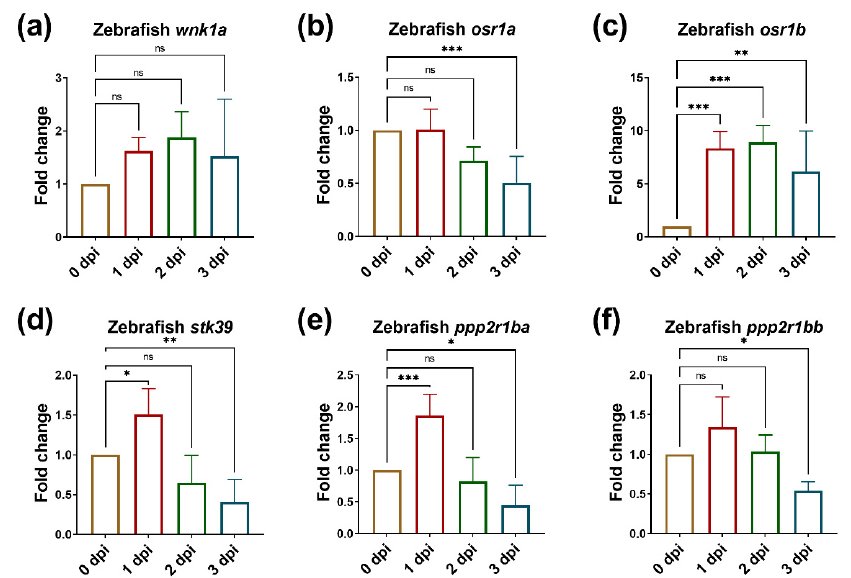
Figure 3. The expressions of wnk1a and osr1b are upregulated in endothelial cells during tumor- induced angiogenesis. The expression of wnk1a and its downstream effectors during tumor-induced angiogenesis. ( a ) wnk1a , ( b ) osr1a , ( c ) osr1b , ( d ) stk39 , ( e ) ppp2r1ba and ( f ) ppp2r1bb in zebrafish em- bryos from 0 dpi to 3 dpi during tumor-induced angiogenesis. We performed three to four repli- cates, and for each qPCR, there were triplicates for each sample. Thirty embryos were included in